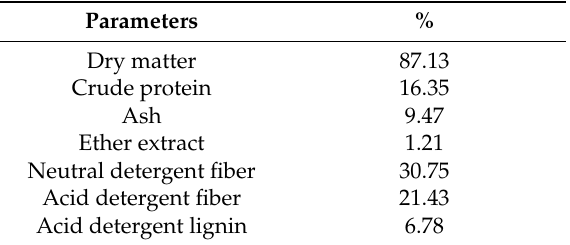
Table 1. Chemical composition of the alfalfa diet composition.